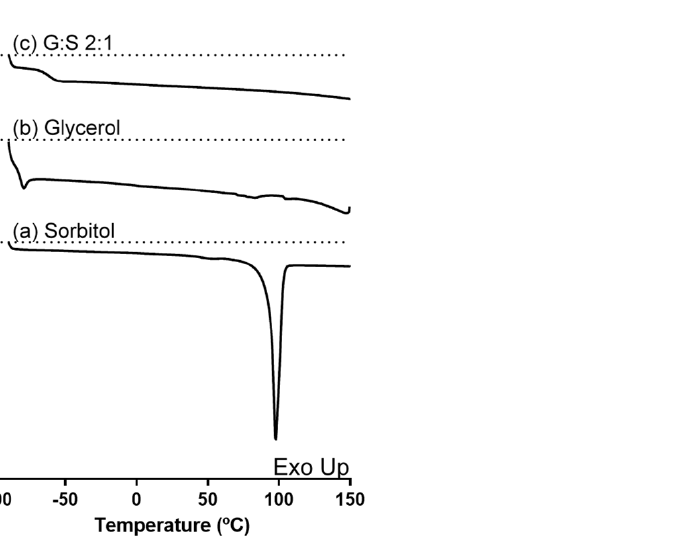
Figure 1. DSC thermogram of ( a ) sorbitol, ( b ) glycerol, and ( c ) G:S 2:1 molar ratio.